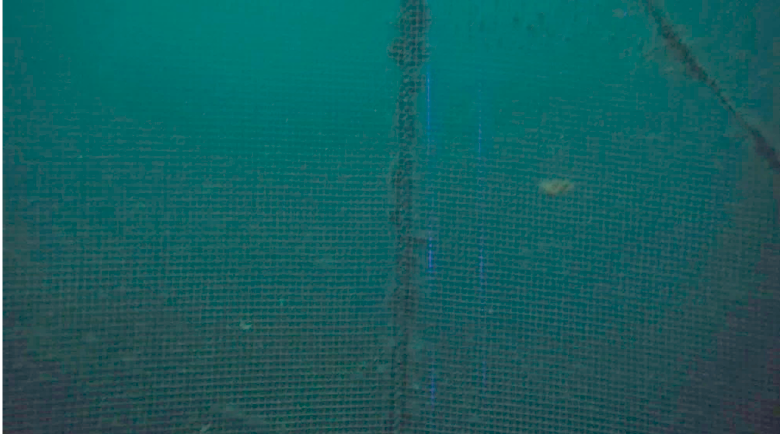
Figure 10. A picture taken at t = 1020 s, where the triangulation data is significantly more noisy than the DVL distance. Weak laser signal due to large distance (>2.5 m) to the net makes the laser triangulation loose data. The image is brightness-corrected for display purposes.